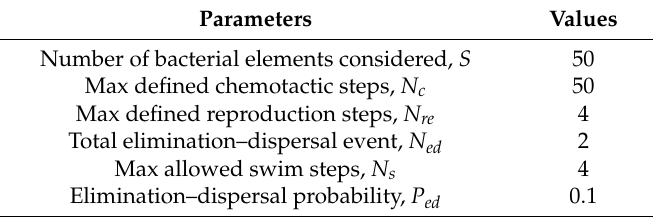
Table 2. Input parameters in the bacteria foraging optimization (BFO)